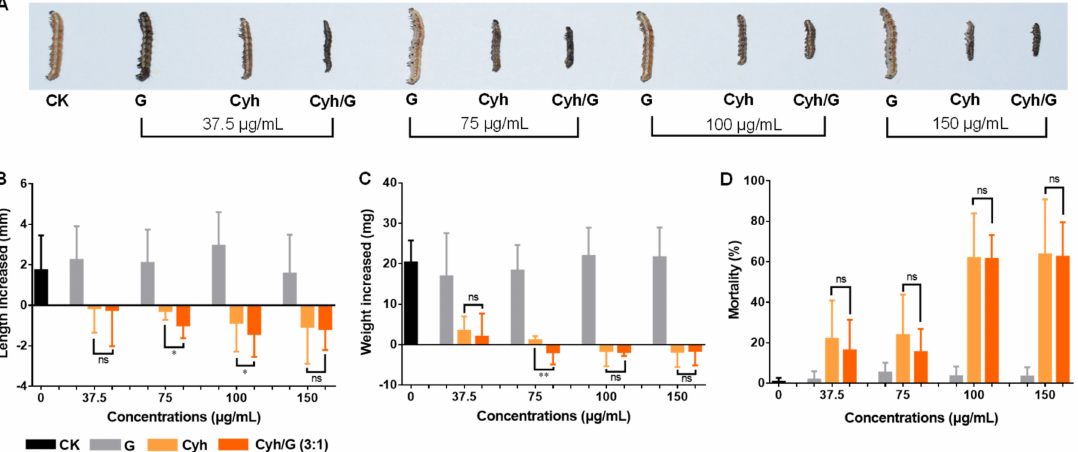
Figure 6. Insecticidal activity of different concentrations of graphene, Cyh, and Cyh/G against cotton bollworm. ( A ) Phenotypic effects. ( B ) Body length change, ( C ) weight change, and ( D ) mortality of the cotton bollworm. CK represents distilled water control. Note: statistically significant differences ( α = 0.05 and 0.01 levels) of values are indicated with “*” and “**”, respectively. “ns”: not